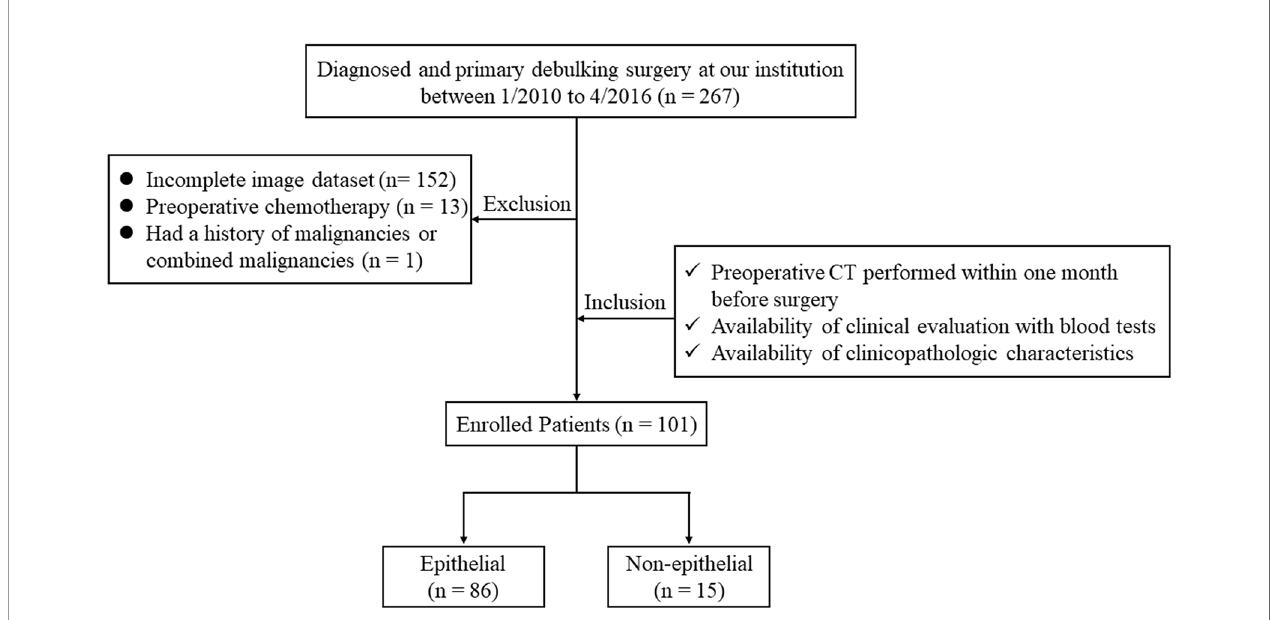
FIGURE 1 | The fl owchart of the case identi fi cation